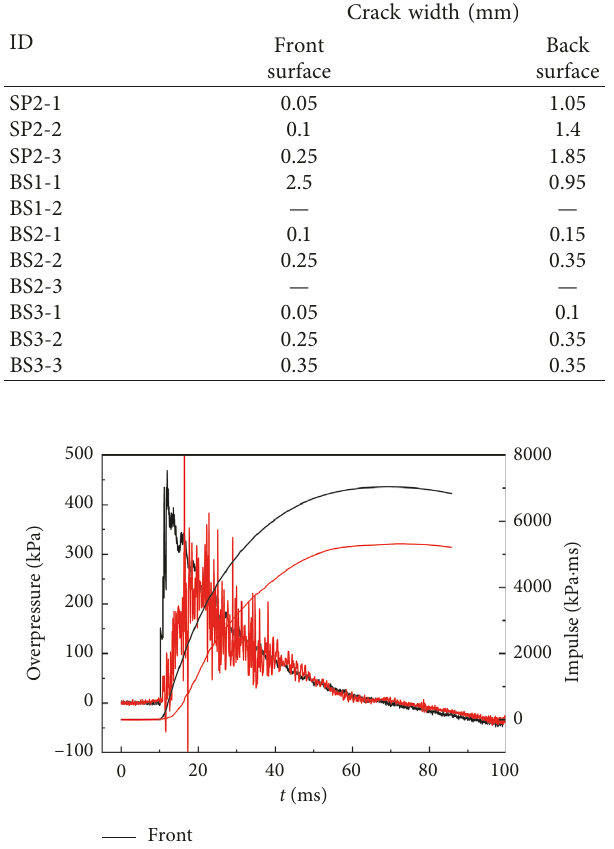
Table 5: Crack width of slabs.